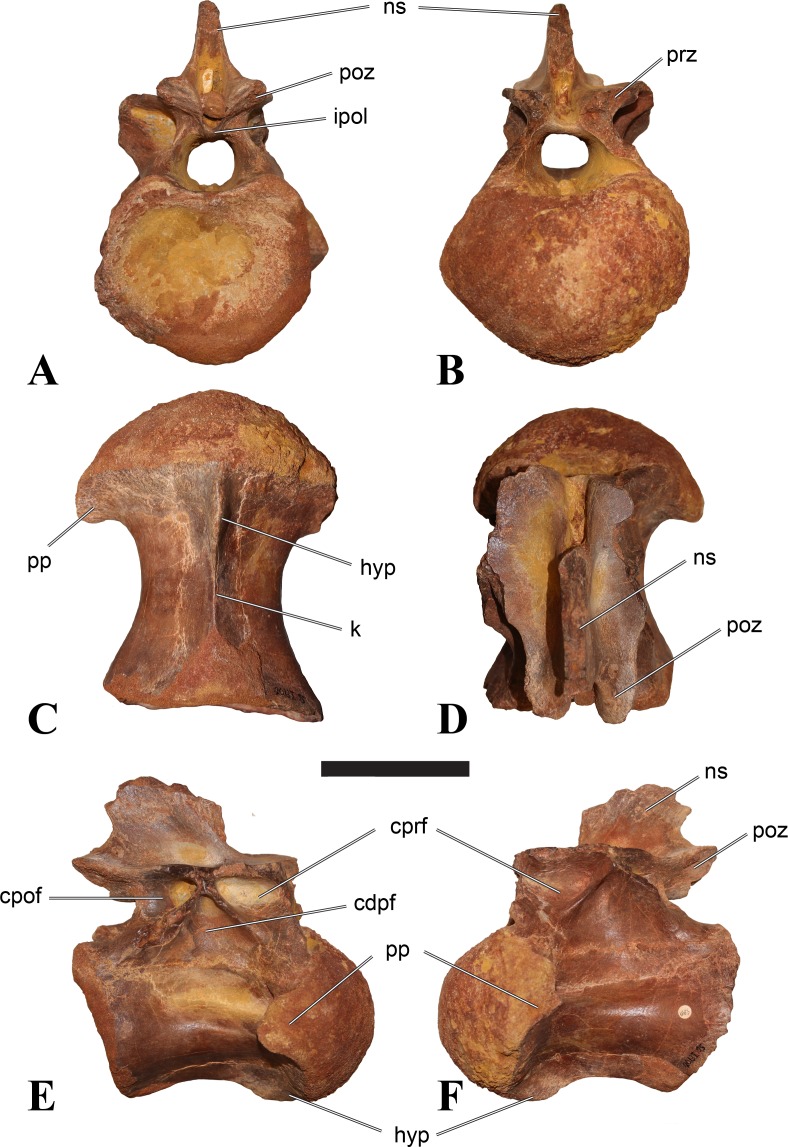
BSPG 2013 I 95, anterior dorsal vertebra tentatively referred to Sigilmassasaurus.(A) posterior view; (B) anterior view; (C) ventral view; (D) dorsal view; (E) right lateral view; (F) left lateral view. Abbreviations: cdpf, centrodiapophyseal fossa; cpof, centropostzygapophyseal fossa; cprf, centroprezygapophyseal fossa; hyp, hypapophysis; ipol, interpostzygapophyseal lamina; k, keel; ns, neural spine; poz, postzygapophysis; pp, parapophysis; prz, prezygapophysis. Scale bar equals 5 cm.